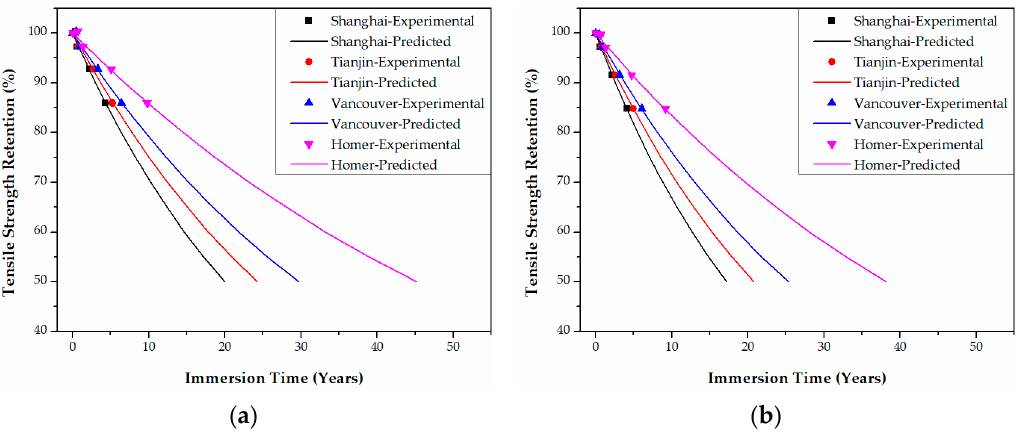
Figure 20. Life prediction of the tensile strength for unstrained epoxy-based CFRPs immersed in distilled water ( a ) and seawater ( b ) in the four cities, respectively.